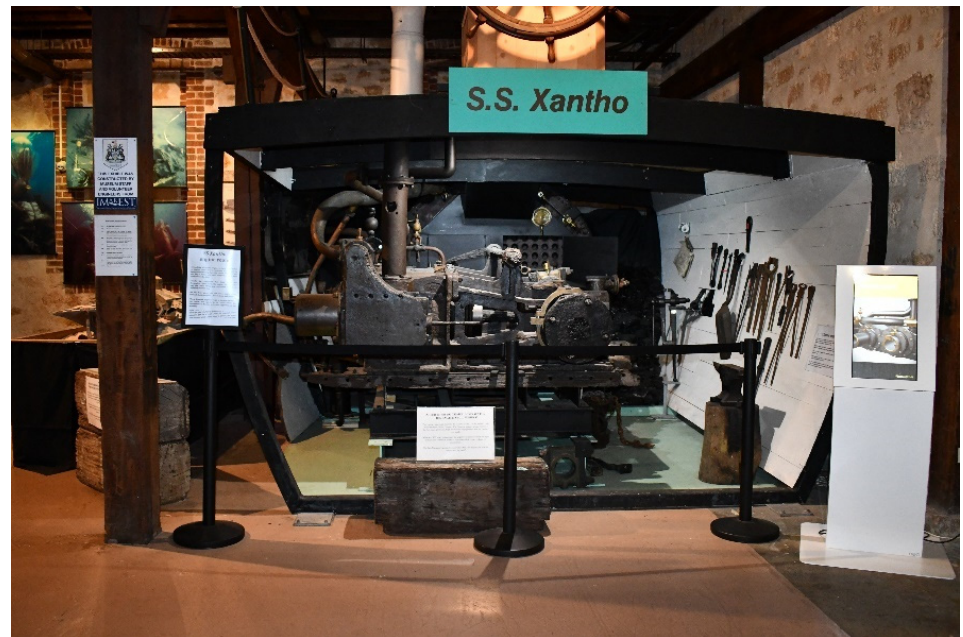
Figure 2. SS Xantho in Western Australia Shipwreck Museum.